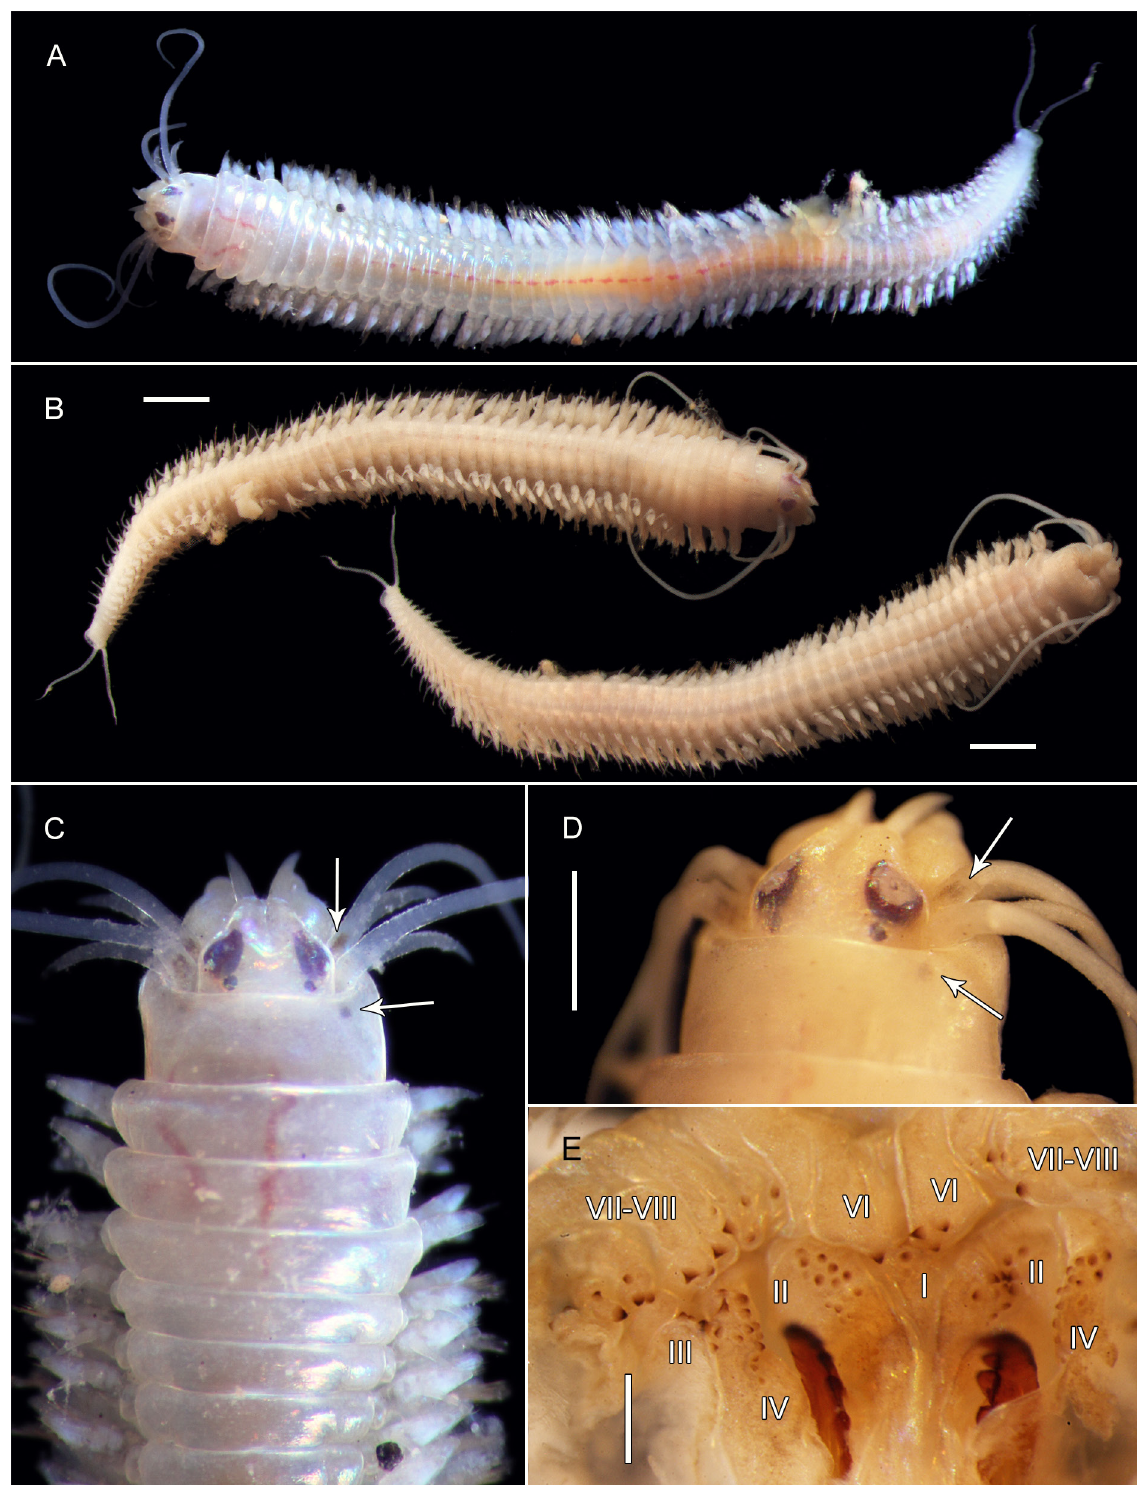
Fig. 2. Neanthes goodayi sp. nov., holotype (NHM_739). A . Live image, entire specimen. B . Preserved entire specimen, dorsal view (left), ventral view (right). C . Live image, anterior view, arrows mark pigmentation. D . Preserved specimen, anterior view, arrows mark pigmentation. E . Dissected pharynx, with pharyngeal areas I, II, III, IV, VI, VII–VIII highlighted. Scale bars: B = 1 mm; D = 500 µm; E = 250